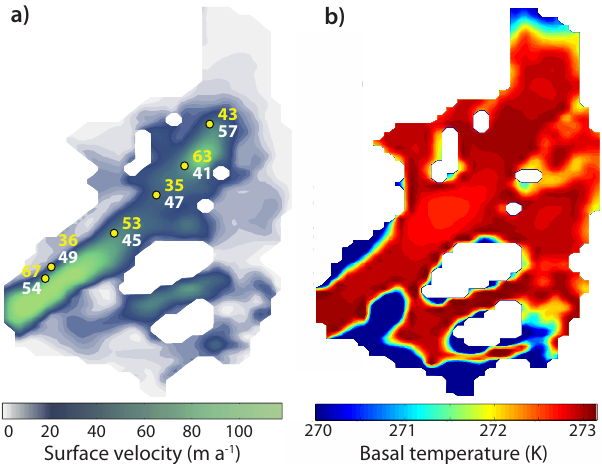
Fig. 15. Distributed map of simulated ice velocities (a) and basal temperatures (b) in 2007 for the φ = 13 ◦ experiment. At the loca- tions of velocity observations, reported in Den Ouden et al. (2010), observed velocities (white) and simulated velocities (yellow) are in- dicated. Only basal temperatures higher than 270K are